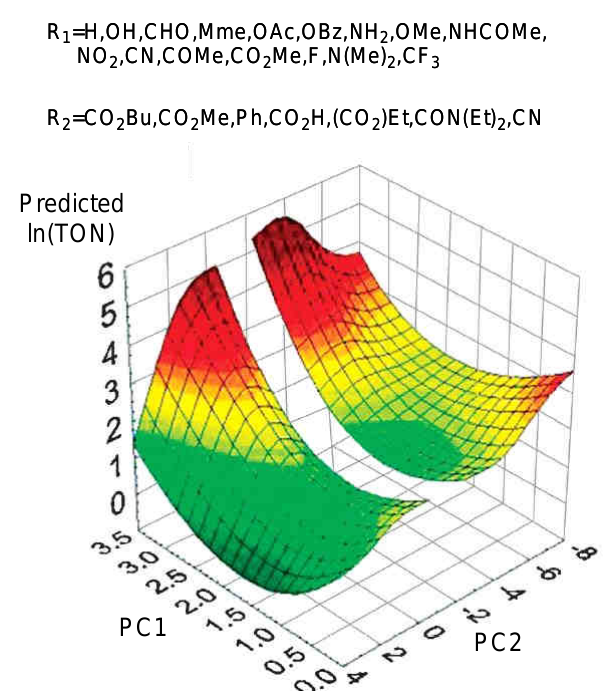
Figure 10 . (top) General Heck reaction dataset. Ligands: monophosphines and monophosphites; solvents: DMF, THF, DMA, dioxane, Et N, PhMe, NMP, MeCN, EtCN, PrCN, HMPT and 1,2-DCE; 3 (bottom) Predicted TON values for 60,000 virtual cross-coupling reactions are plotted versus the first two PCs calculated for all the reaction descriptors. The first PC is correlated mainly with the Pd . The second PC loading and the electronic descriptors of the organic residue on the alkene, R 2 represents mainly the ligand’s electronic